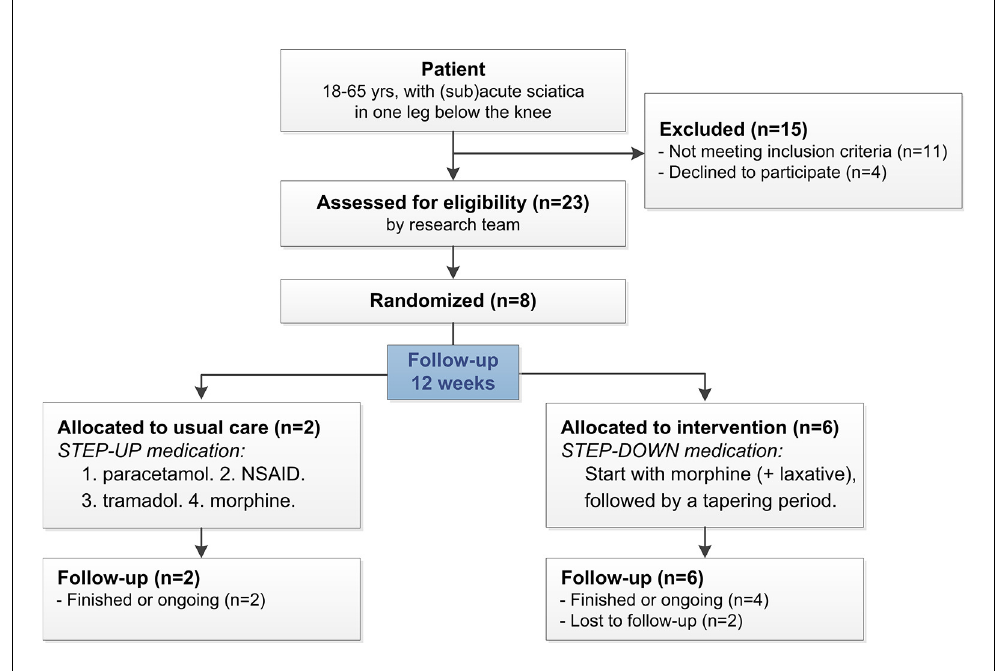
Figure 1. Flow diagram of the STEP-UP trial (pragmatic design